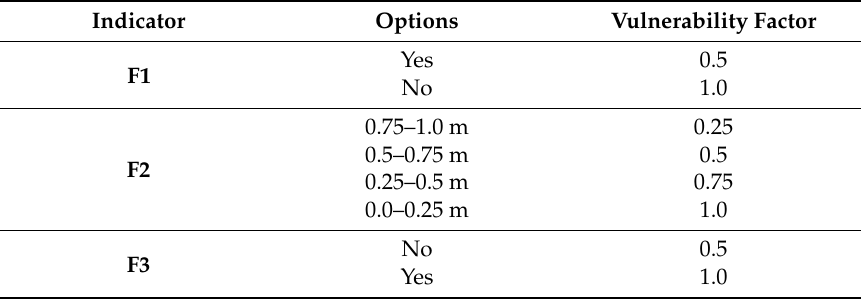
Table 3. Vulnerability scale for flood hazard.